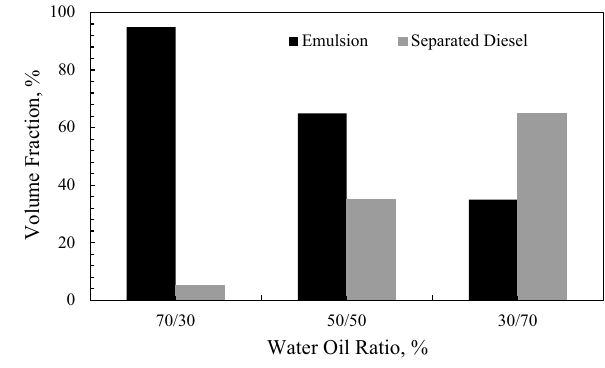
Fig. 7 Volume fraction of the emulsified gels at different emulsifier concentrations after 1 week at 25 °C